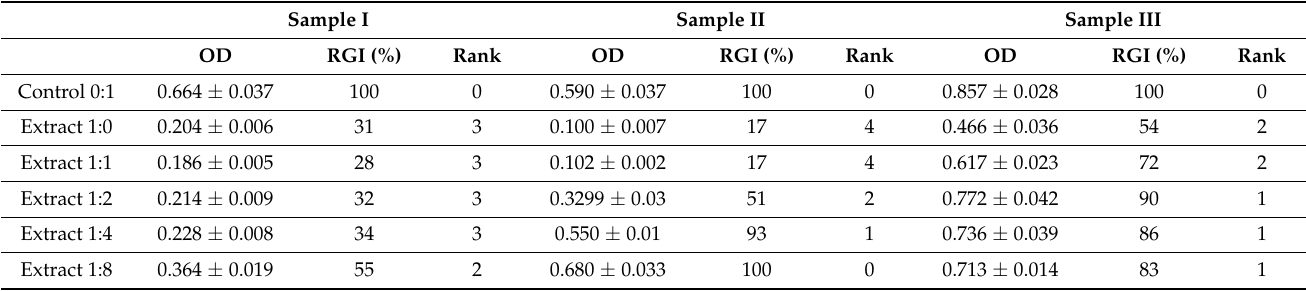
Table 5. Cytotoxicity assessment of collagen and PAA copolymer samples synthesized at 60 ◦ C taken directly from synthesis (Sample I), freeze-dried (Sample II), and both freeze-dried and washed to remove unreacted AA (Sample